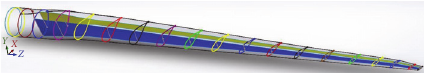
Figure 7: NREL 5MW blade 3D model.